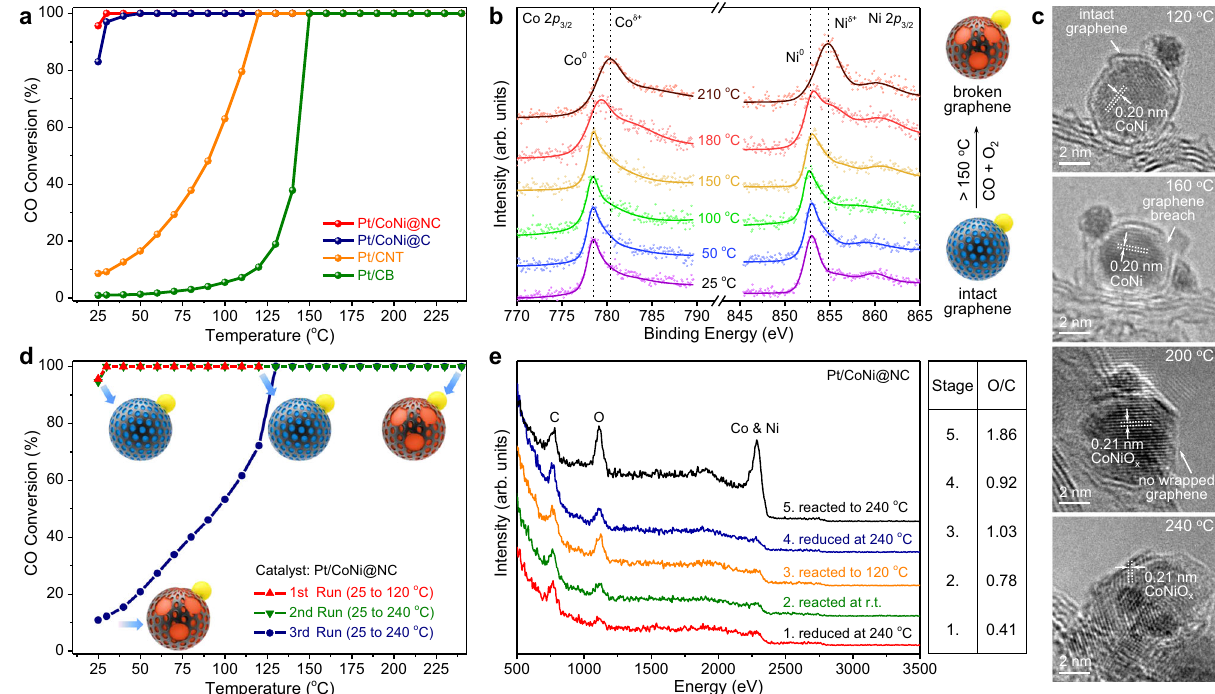
Fig. 2 Structure – activity relationship of Pt on graphene encapsulating CoNi alloy for CO oxidation. a Temperature-dependence CO conversion in CO oxidation reaction over the pre-reduced catalysts. 1% CO and 20% O 2 in He (1 bar). Space velocity: 60,000 mL g − 1 h − 1 . b XPS spectra of Co 2 p 3/2 and Ni 2 p 3/2 from NAP-XPS testings over Pt/CoNi@NC in a fl ow of 0.067 mbar CO and 1.13 mbar O 2 at different reaction temperatures. c TEM images of Pt/ CoNi@NC after reacting to certain temperatures. d Temperature-dependence CO conversion in CO oxidation cycle testings over Pt/CoNi@NC. 1% CO